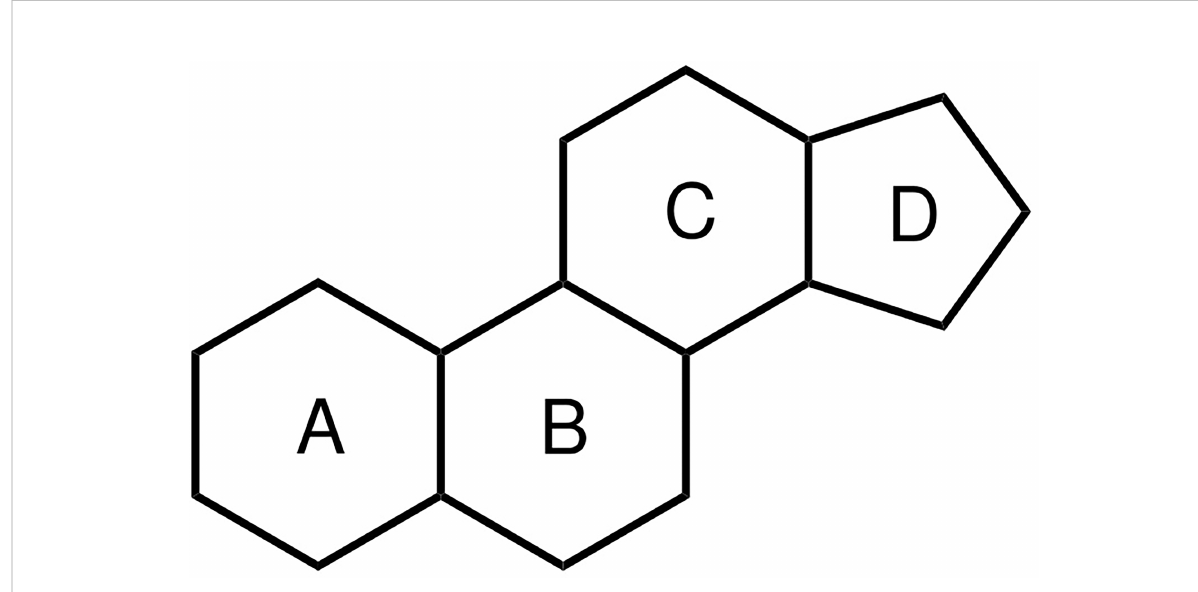
FIGURE 1 Chemical structure of the steroid nucleus consisting of three cyclohexane rings (A – C) and one cyclopentane ring (D)